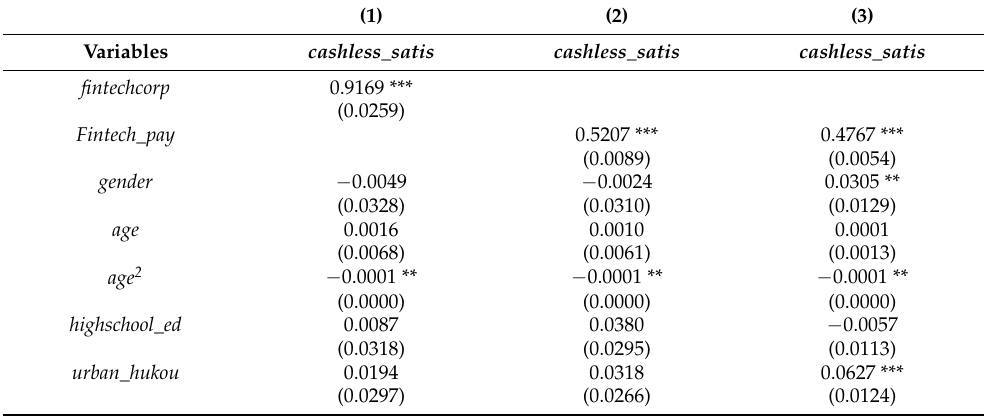
Table 4. Robustness Checks: Changing the independent variable, excluding outliers, and alleviating the impact of targeted poverty